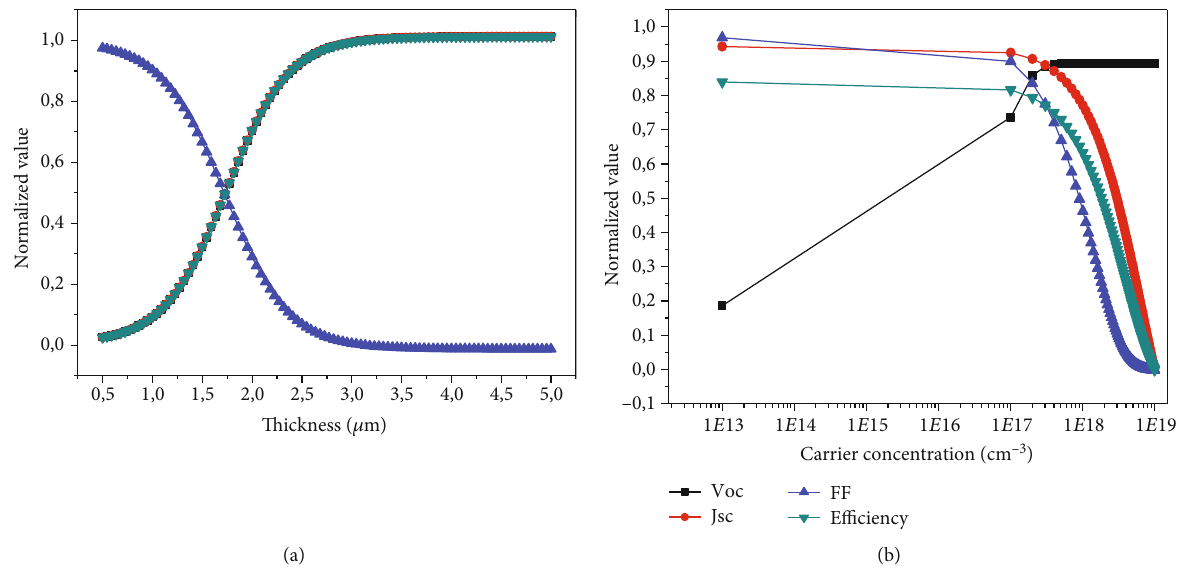
Figure 5: Calculated normalized output parameters of CFTS solar cell as a function (a) of the thickness and (b) of carrier concentration in the CFTS absorber